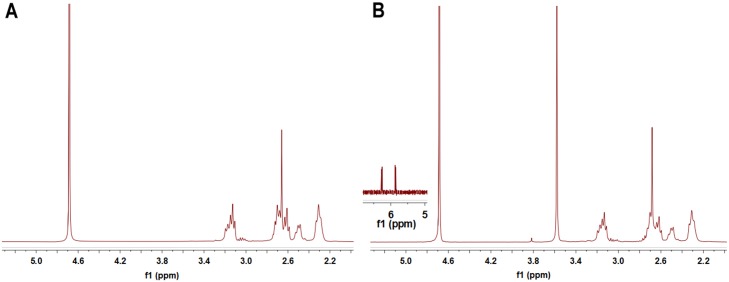

1H-NMR of PAMAM (A) and PAMAM-PEG-MAL (B) in D2O.